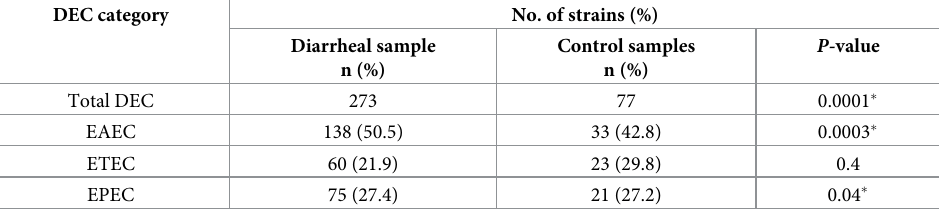
Table 5. Distribution of DEC pathotypes among diarrheal and healthy children.